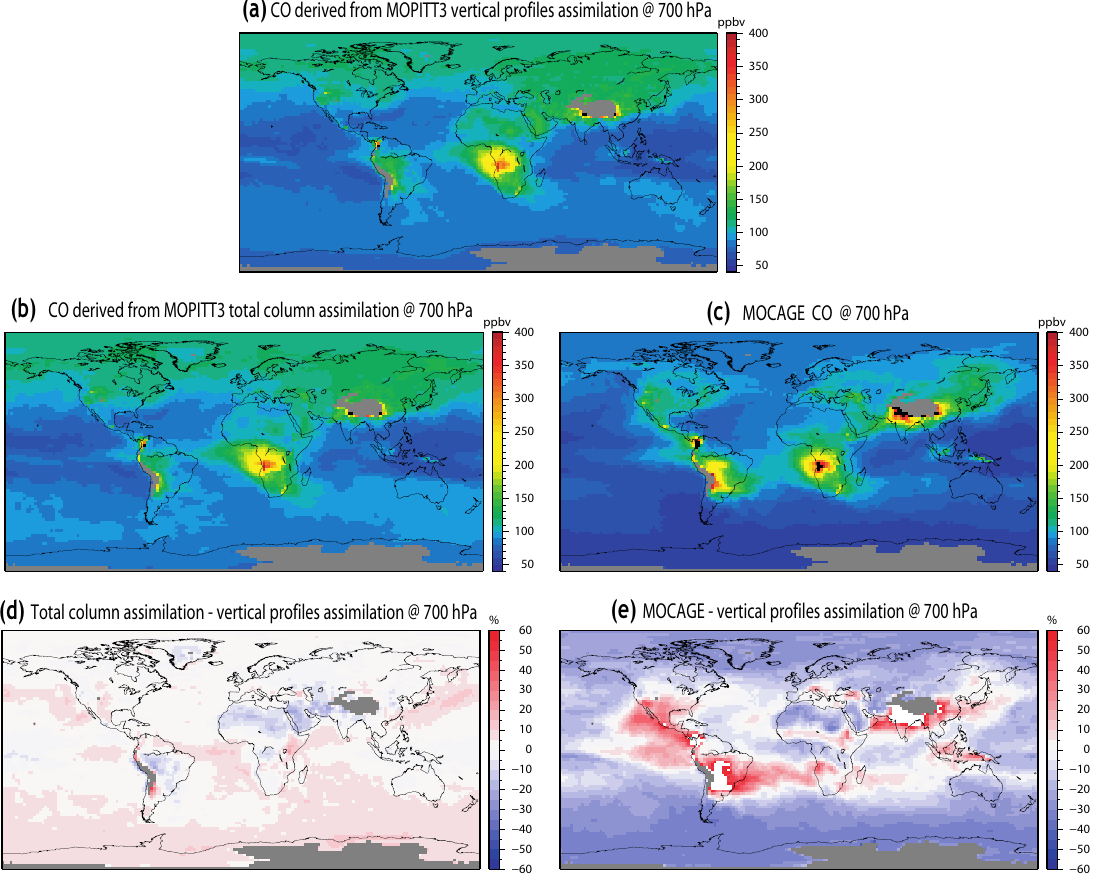
Figure 10. Maps of CO field at 700hPa for (a) MOPITT PROFILE_ANALYSES taking into account averaging kernels and observation Fig. 10. Maps of CO field at 700 hPa for: (a) : MOPITT PROFILE ANALYSES taking into account aver- error covariance matrices, (b) MOPITT TOTCOL_ANALYSES, and (c) the MOCAGE free-run field. The figures at the bottom present the difference in percent between TOTCOL_ANALYSES and PROFILE_ANALYSES (d) , and the difference between the model and PRO- aging kernels and observation error covariance matrices; (b) : MOPITT TOTCOL ANALYSES, and (c) : the FILE_ANALYSES (e) MOCAGE free-run field. The Figures in the bottom present the difference in % between TOTCOL ANALYSES and PROFILE ANALYSES (d) , and the difference between the model and PROFILE ANALYSES (e) .